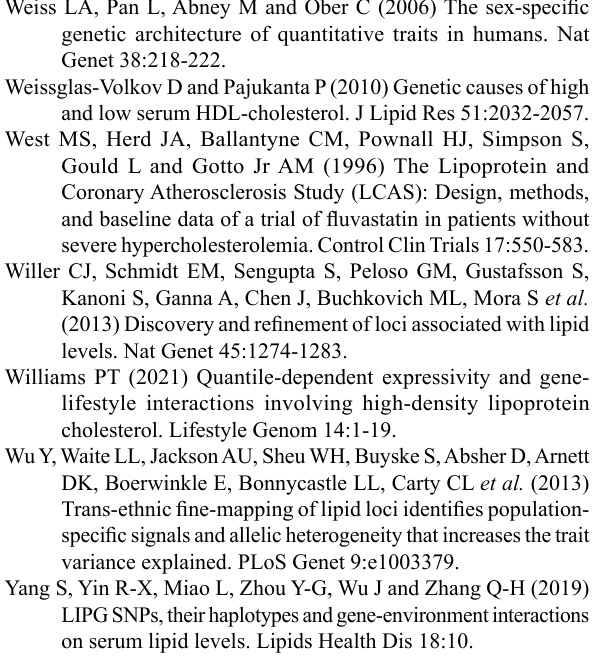
Table S1 – Information of genetic variants relating to low- HDL-C in males. Table S2 – Information of genetic variants relating to low- HDL-C in females. Table S3 – Gene functions which are sex-specifically